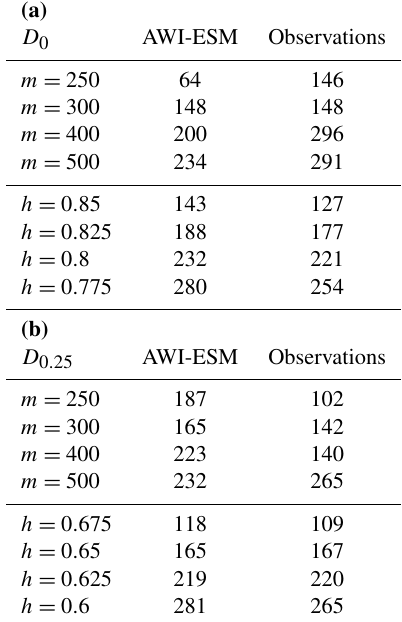
Table 1. The number of clusters for the AWI-ESM climate model and observational data determined with the L Method ( m data) and the threshold method ( h data) for different ranges and thresholds and for the dissimilarity measures D 0 (a) and D 0 . 25 (b)